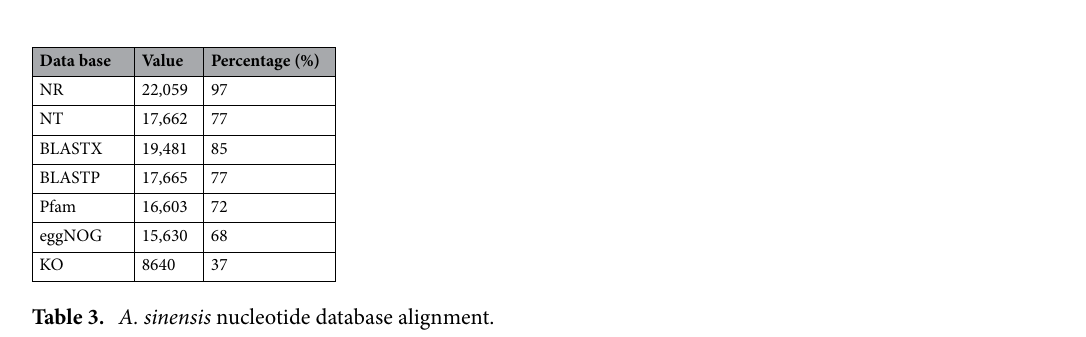
Table 3. A. sinensis nucleotide database